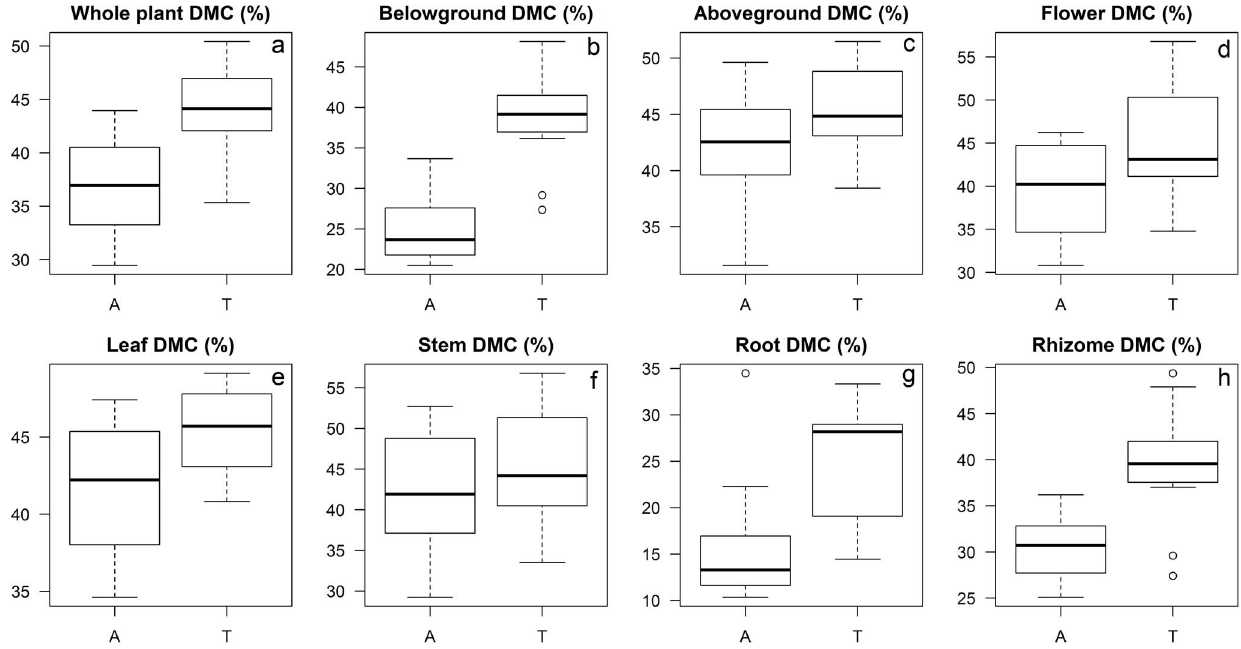
Figure 1. The dry matter content (DMC) of aquatic (A) and terrestrial (T) reed for the (a) whole plant, (b) belowground part, (c) aboveground part and (d–h) separate organs (the solid lines in the boxes indicate median values, the upper and lower ranges of the boxes show the third and first quartiles whereas upper and lower lines out of the boxes indicate the maximum and minimum values, extreme values are shown as dots, analogously for Figure 2).